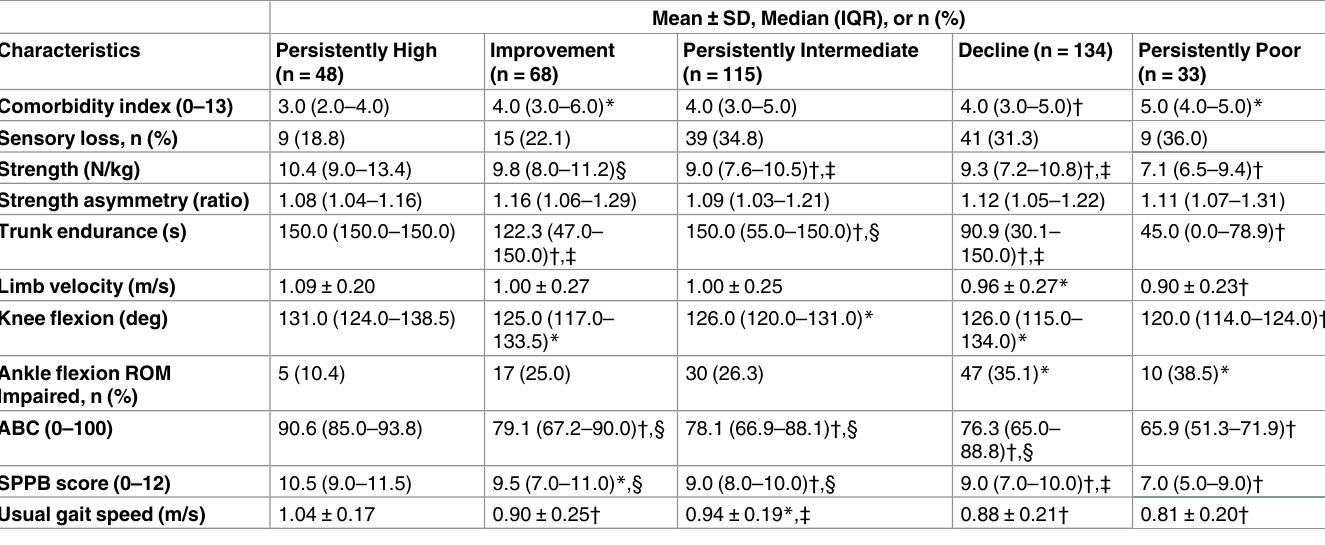
(Fig 2). Both the persistently poor ALE and BLE mobility trajectories had the weakest leg strength and trunk extensor endurance, poorest balance confidence scores, worst SPPB scores, and slowest gait speed, while those in the persistently high mobility trajectories had the best leg Table 2. Baseline health and function by ALE mobility trajectoryover 2 year follow-up (N = 391). Mean ± SD, Median (IQR), or n (%)